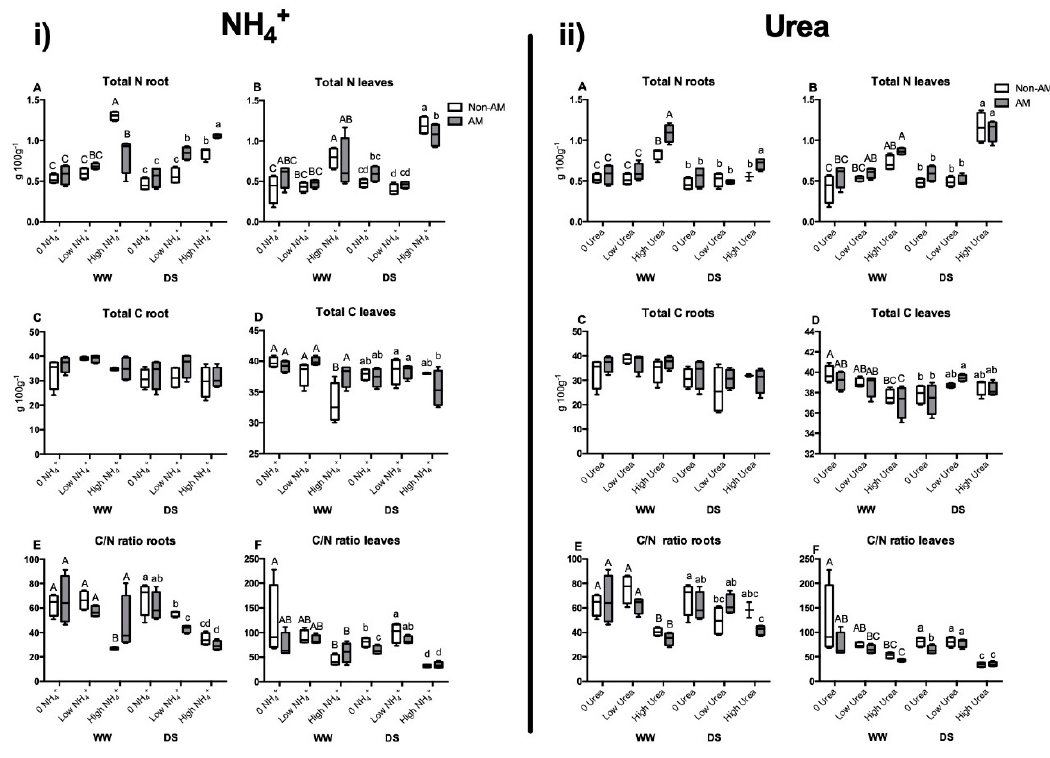
Figure 3. Total N (( i ) A , B ) for NH 4 + experiment and ii A and ii B for the urea experiment) and C (( i ) C ) and (( i ) D ) for NH 4 + experiment and (( ii ) C ) and (( ii ) D ) for the urea experiment) and ratio C / N (( i ) E ) and (( i ) F ) for NH 4 + experiment and (( ii ) E ) and (( ii ) F ) for the urea experiment) in roots and leaves of maize plants inoculated or not with the AM fungus Rhizophagus irregularis (AM), submitted to two water regimes (well-watered, WW or drought stress, DS, for 14 days) and grown under di ff erent ammonium or urea concentrations (0 N added; low N, 3 µ M or high N, 10 mM). Data represents the means of five biological replicates ± SE. Di ff erent letter (uppercase for WW treatments and lowercase for DS treatments) indicates significant di ff erences between treatments ( p < 0.05) based on Duncan’s